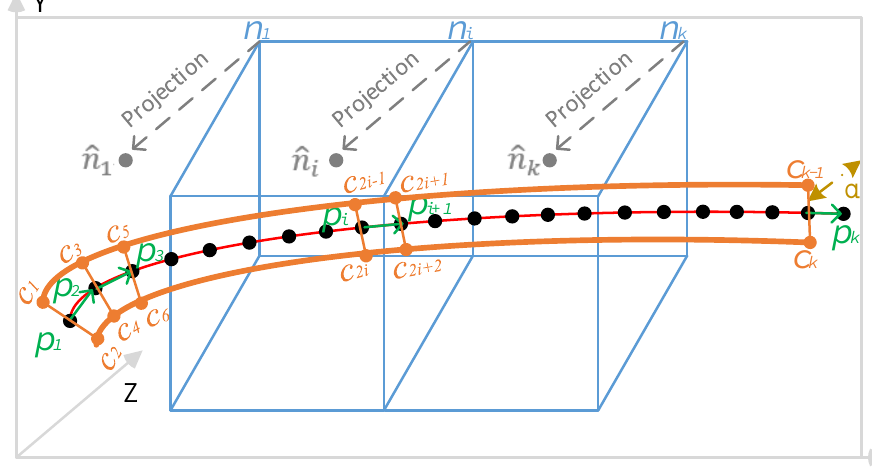
Figure 3. Schematic of RBF